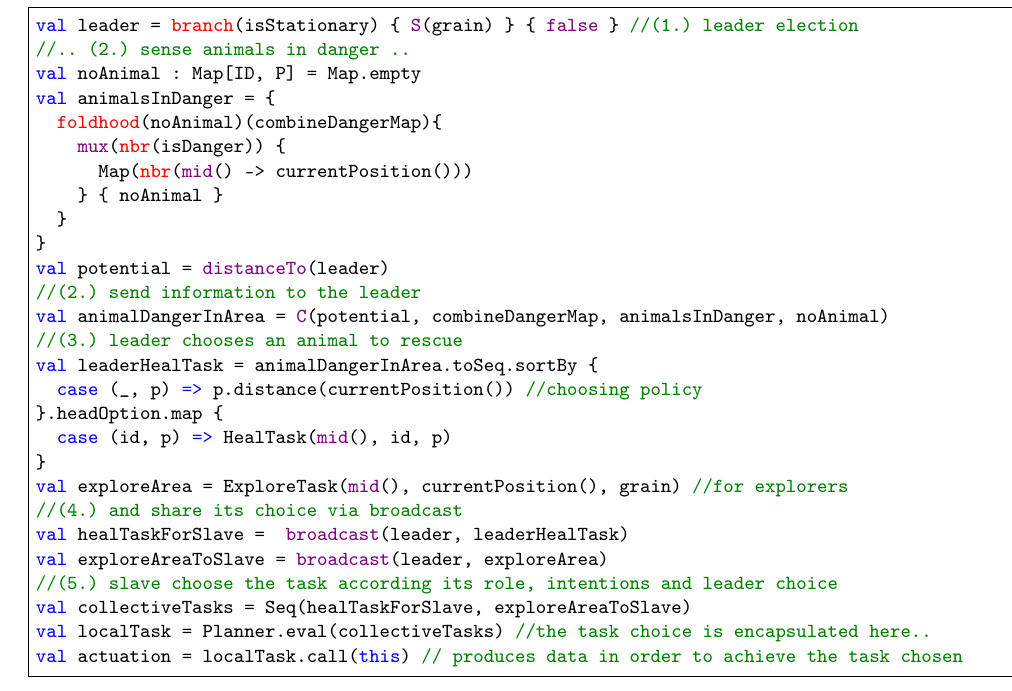
Figure 3. Wildlife monitoring and rescue example: architecture and program. ( a ) Diagram corresponding to the code below. This figure uses the same notation of Figure 2b. In addition, we use a same colour to denote multiple references to the same functional block. ( b ) The ScaFi code snippet for the wildlife program